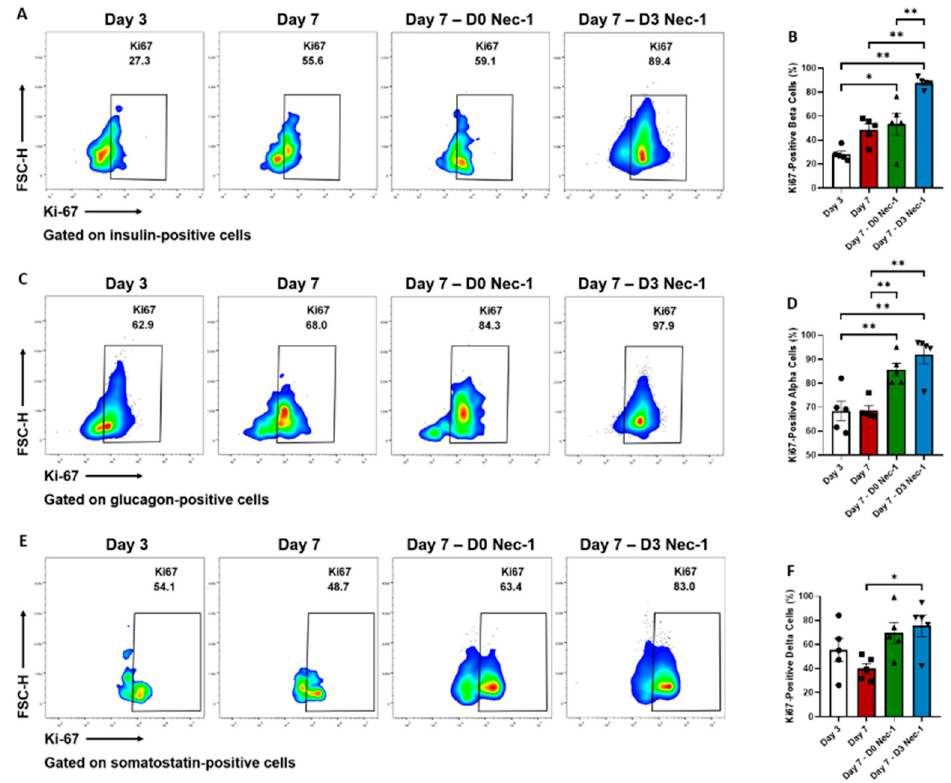
Figure 4. Flow cytometric analysis of proliferating endocrine cells of PPIs on day 3 and 7 of tissue culture in control media or media supplemented with Nec-1 either immediately after islet isolation (D0 Nec-1) or on day 3 of tissue culture (D3 Nec-1). Islets were dissociated on day 3 and 7 of tissue culture using Accutase, stained with 7-AAD viability dye, anti-Ki-67, anti-insulin, anti-glucagon, and anti-somatostatin antibodies, and analyzed by flow cytometry. ( A ) Representative flow cytometry plots of Ki-67 staining of live insulin-positive islet cells on day 3 and 7 of tissue culture. ( B ) The percentage of Ki-67-positive, insulin-positive beta cells on day 3 and 7 of tissue culture. ( C ) Representative flow cytometry plots of Ki-67 staining of live glucagon-positive islet cells on day 3 and 7 of tissue culture. ( D ) The percentage of Ki-67-positive, glucagon-positive alpha cells on day 3 and 7 of tissue culture. ( E ) Representative flow cytometry plots of Ki-67 staining of live somatostatin-positive islet cells on day 3 and 7 of tissue culture. ( F ) The percentage of Ki-67-positive, somatostatin-positive delta cells on day 3 and 7 of tissue culture. n = 5 for each group. * p < 0.05. ** p < 0.01.Individual data points for islets cultured in control media on day 3 (Day 3) or day 7 of tissue culture (Day 7) or in media supplemented with Nec-1 either immediately after islet isolation (D0 Nec-1) or on day 3 of tissue culture (D3 Nec-1) are shown within each bar graph as either circles, squares, triangles, or inverted triangles, respectively. Data expressed as mean ± SEM.